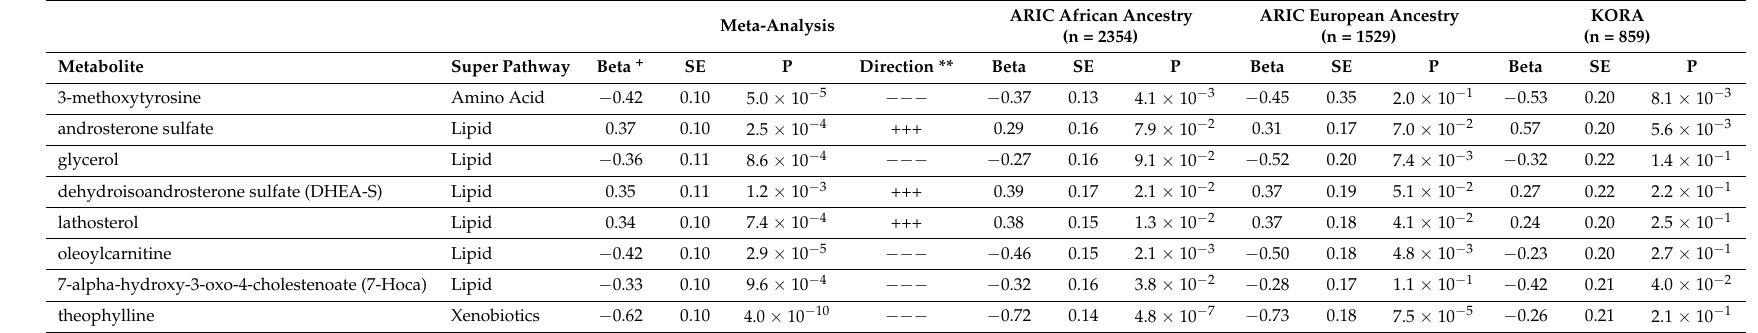
Table 4. Metabolites associated with FEV1/FVC at FDR < 0.05 in meta-analysis